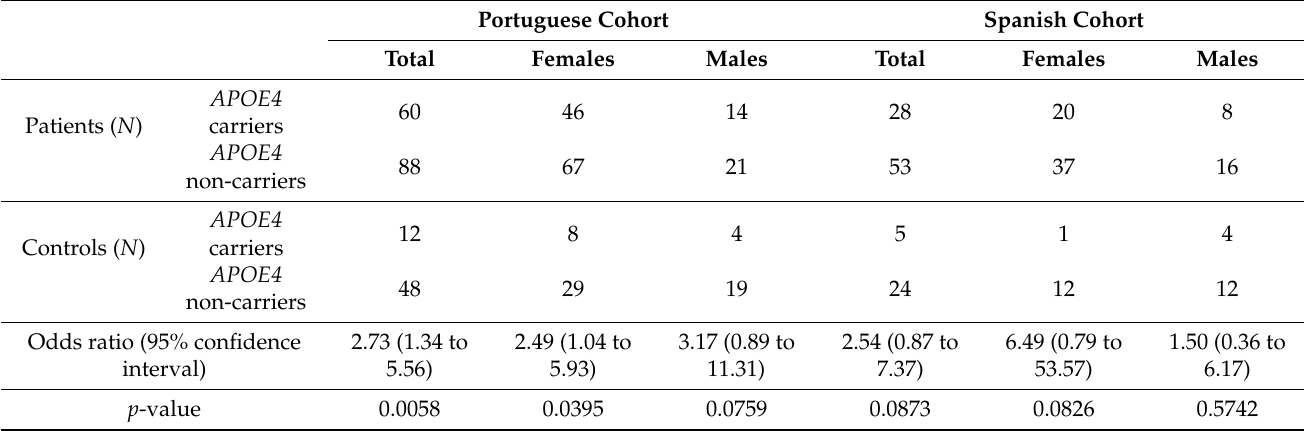
Table 5. Odds ratios of developing late onset Alzheimer’s disease for Apolipoprotein E4 ( APOE4 ) carriers from our analyzed Portuguese and Spanish populations. N : Number of